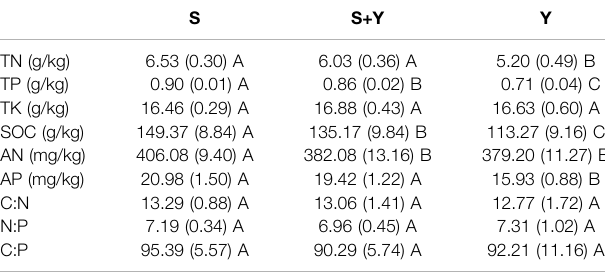
TABLE 2 | Effects of different grazing patterns on soil nutrition in 2021.